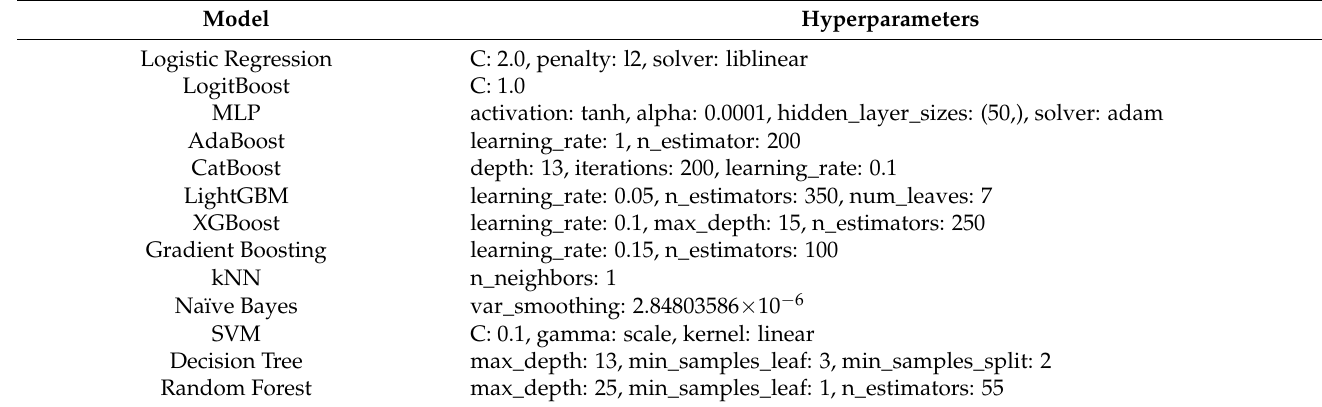
Table 6. Optimal hyperparameters obtained for each model using grid search.